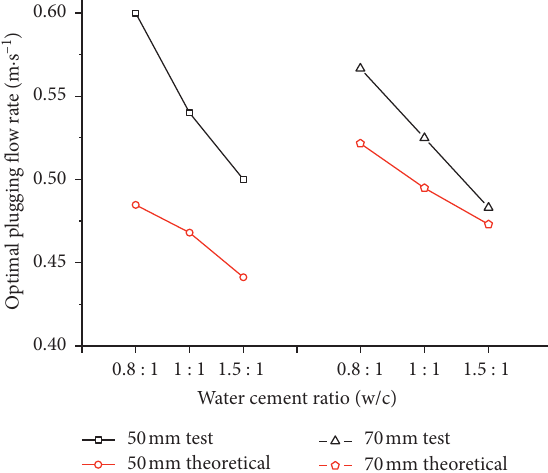
Figure 11: Results of the comparative